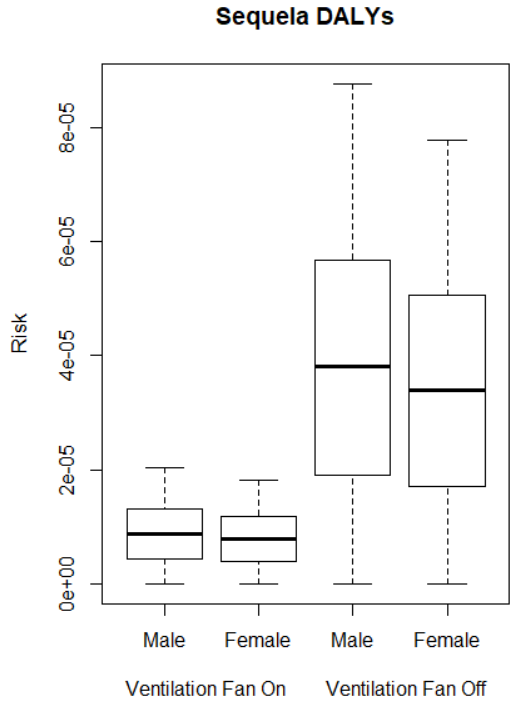
Figure 5. Sequela DALYs for male and female miners.